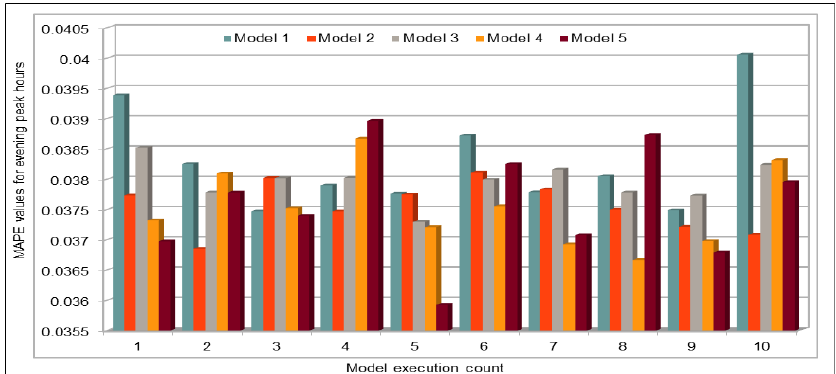
Figure 21. MAPE calculated by comparing actual and predicted vehicles flow on evening peak hours.